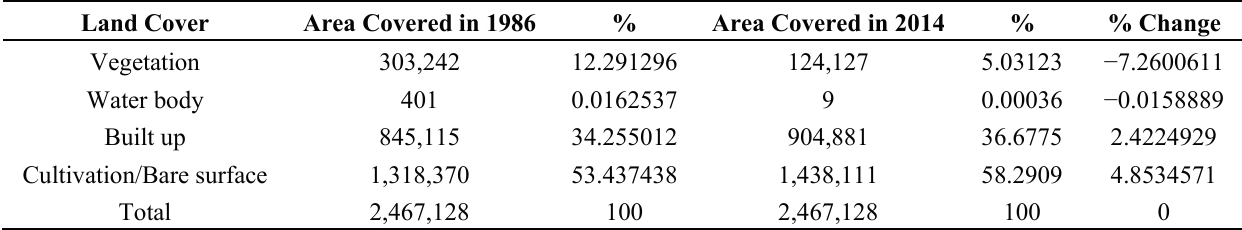
Table 4. Landcover change in